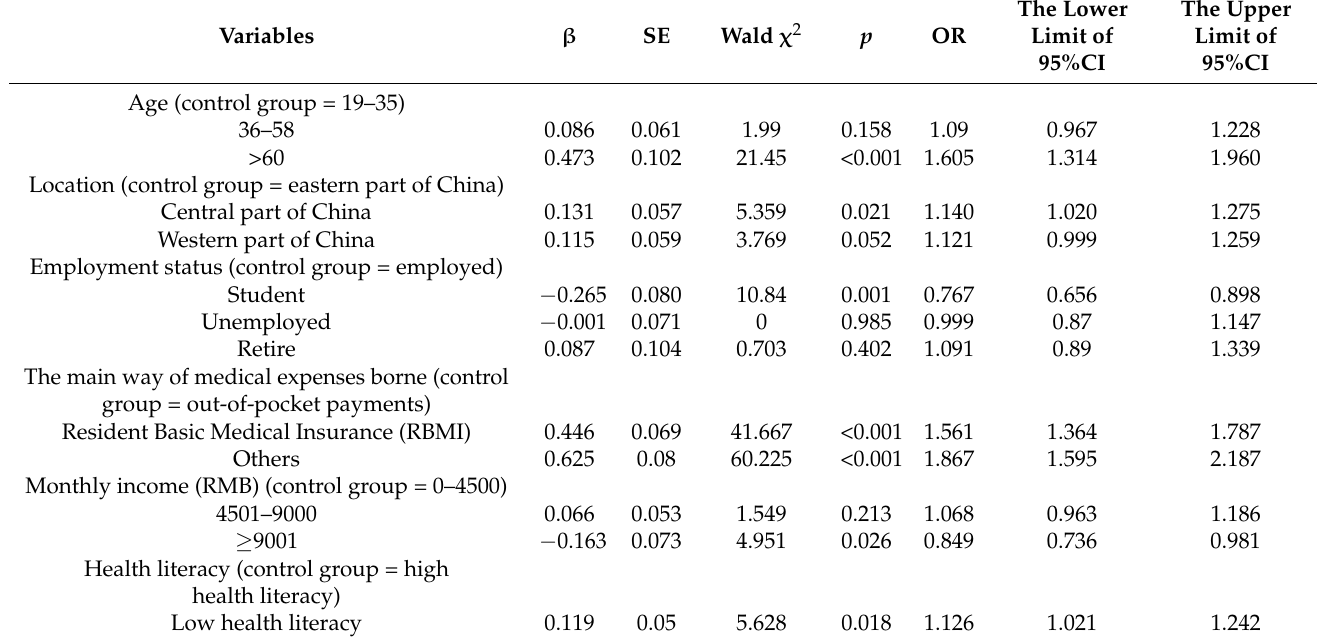
Table 4. Multi-factor binary stepwise logistic regression results with whether the respondents considered drug medical insurance reimbursement as an important factor as the dependent